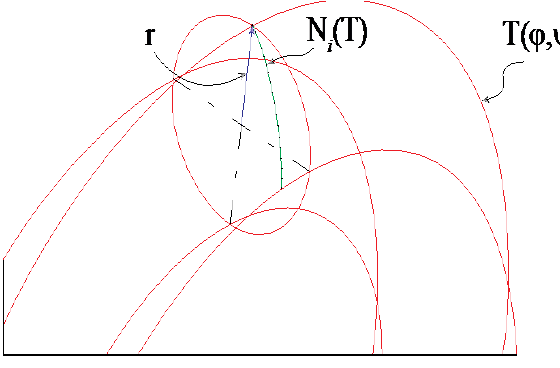
Fig. 2. Toroidal surface with nodal points located on it.